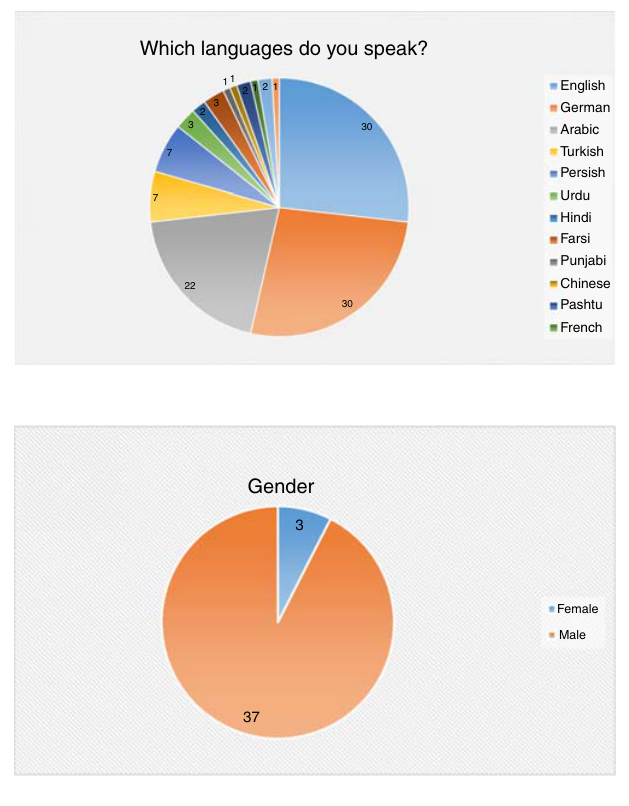
Figure 8. Gender distribution